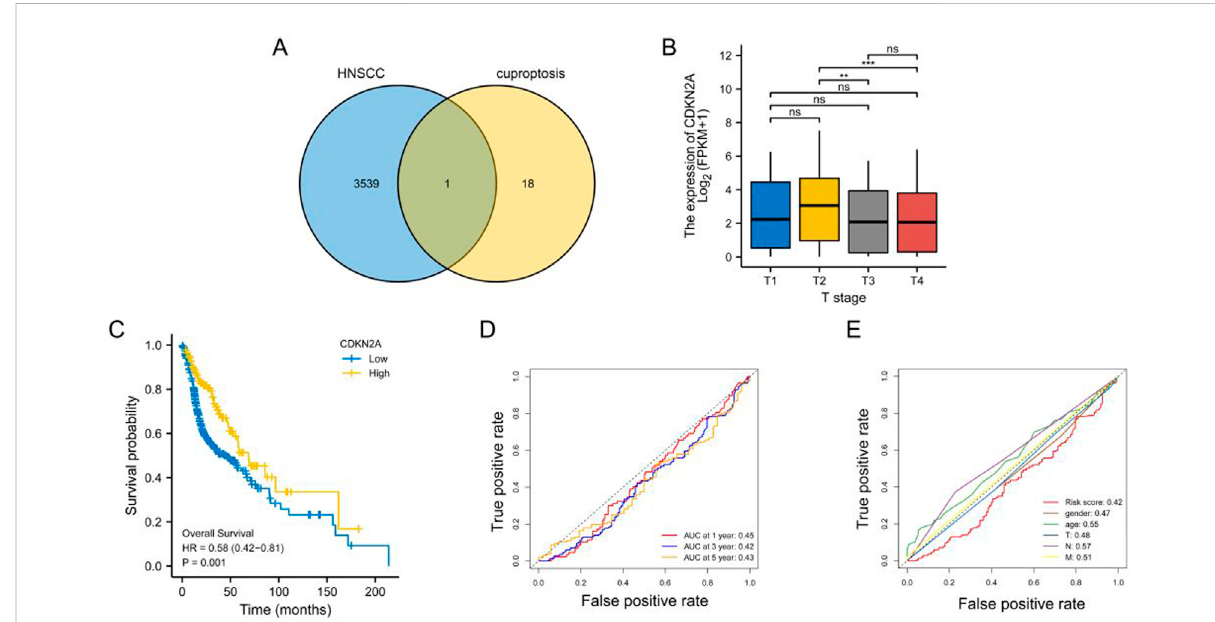
FIGURE 1 Identi fi cation of key genes. (A) Venn diagram demonstrating the results of intersection analysis of differentially expressed genes and cuproptosis-related genes; (B) Bar graph demonstrating the difference in CDKN2A expression among patients with different T stages; (C) KM curve demonstrating a better prognosis for patients with head and neck squamous cell carcinoma with high CDKN2A expression; (D) ROC curve demonstratingthepredictiveperformanceofCDKN2Afor1-,3-and5-yearOS; (E) ROCcurvesdemonstratingtherelationshipbetweenclinical characteristics and the predictive performance of CDKN2A for clinical